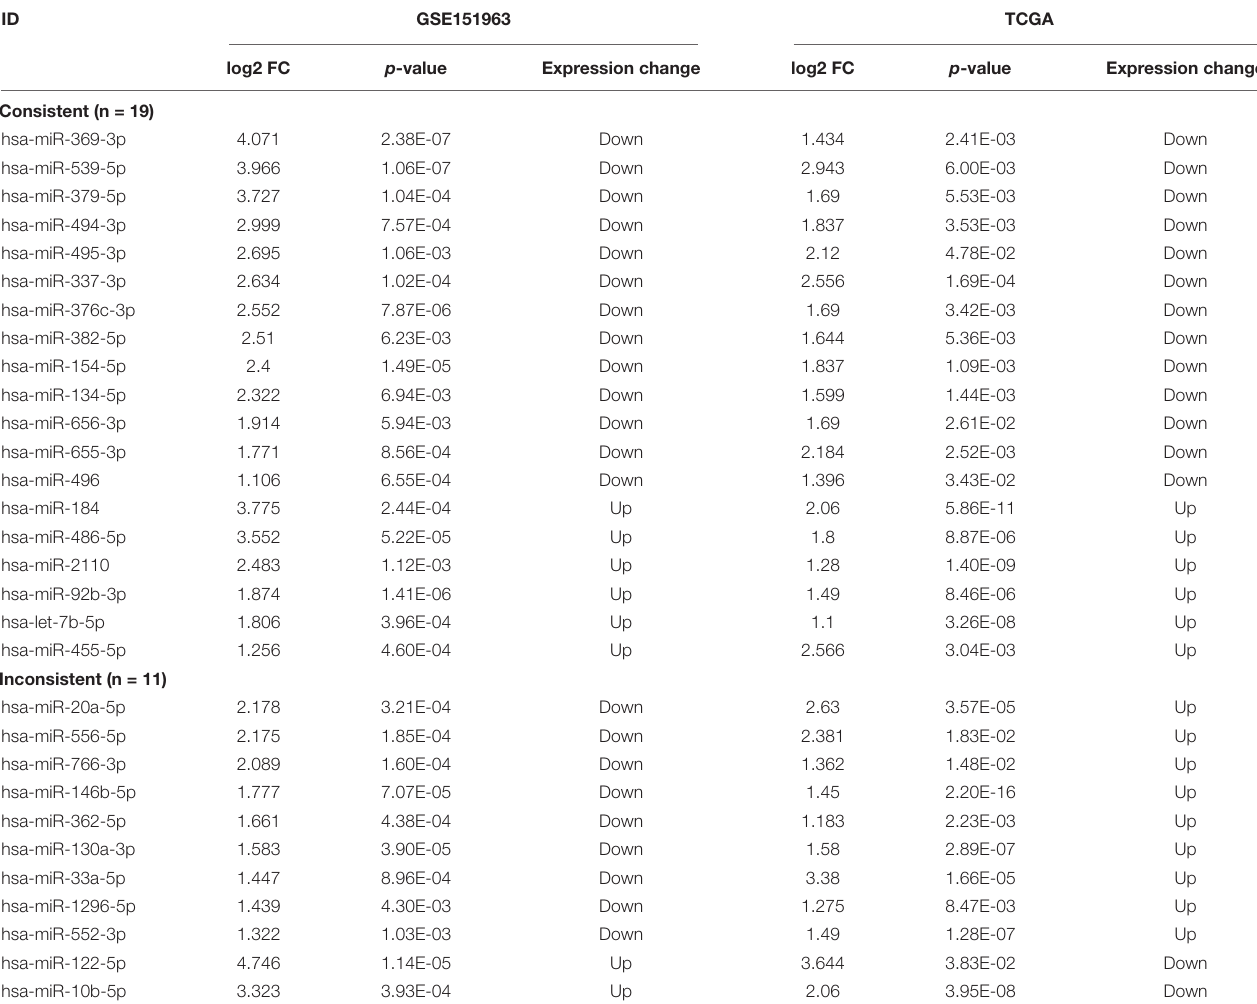
TABLE 1 | Common differentially expressed miRNAs (n = 30) in the GSE151963 and TCGA datasets.